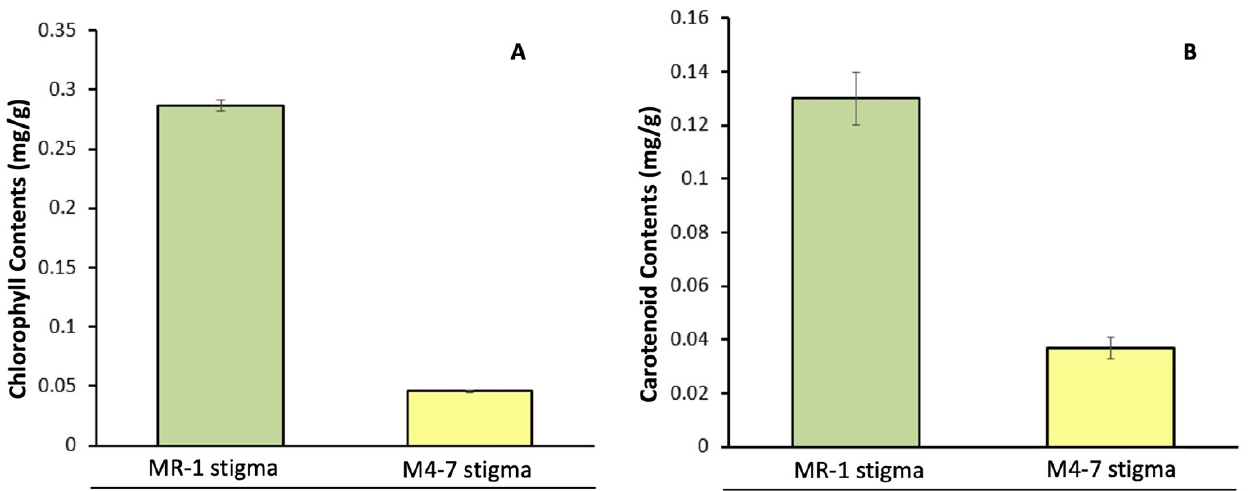
Figure 2. Endogenous pigment quantification in the stigmas of two contrasted melon lines. ( A ) Chlorophyll content; ( B ) carotenoid content.